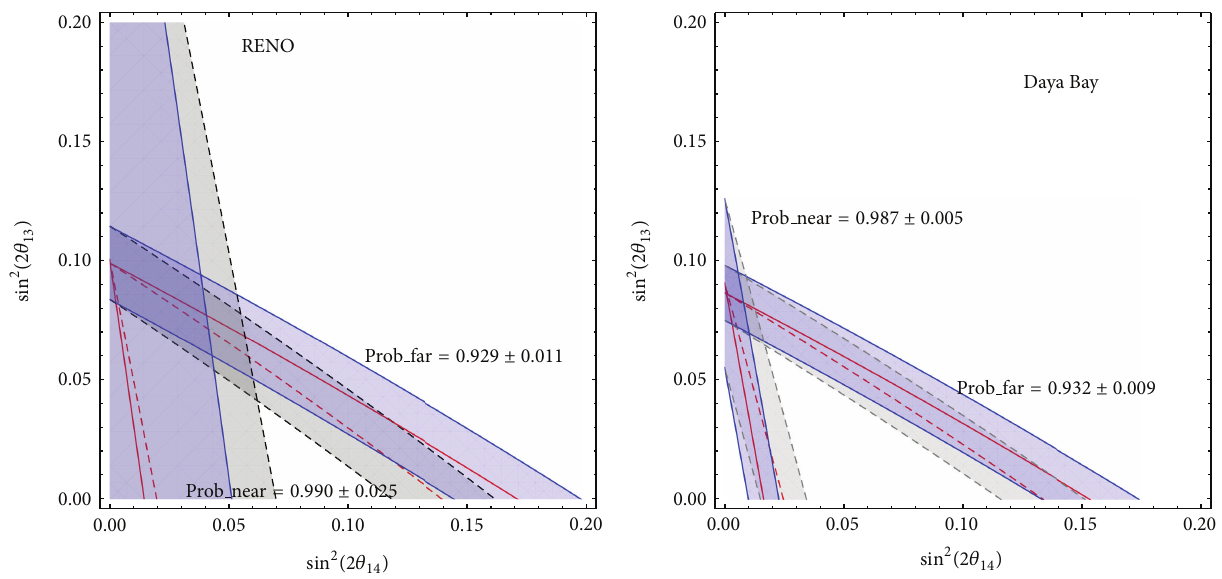
Figure 2: Four-neutrino analysis for the observed to expected ratios at both ND and FD of RENO. The shaded areas indicate the available combination of sin 2 2𝜃 13 and sin 2 2𝜃 14 which is compatible with the ranges of 𝑅 are obtained with Δ𝑚 2 41 = 0.01(0.1) eV 2 . The 4 ] analysis of the far-to-near ratio at Daya Bay is also given for comparison.